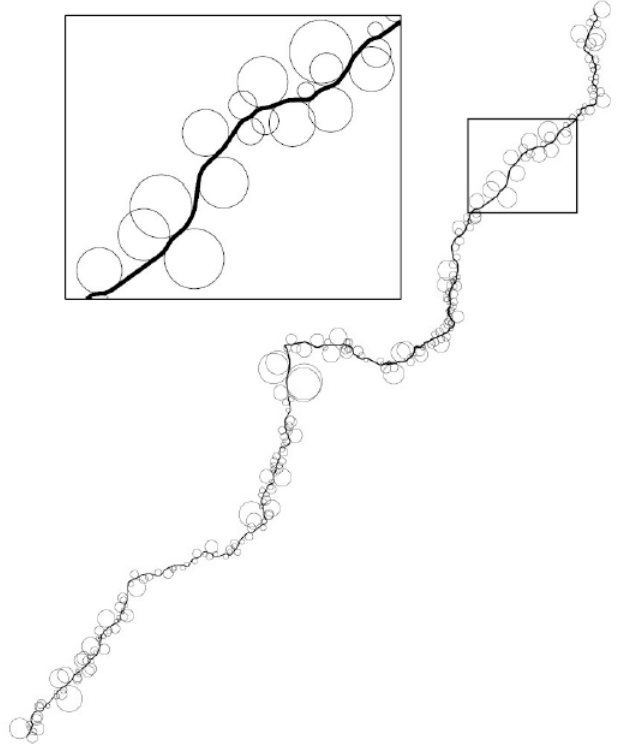
Figure 10. Circumferences obtained by fitting the circular arcs of the road.